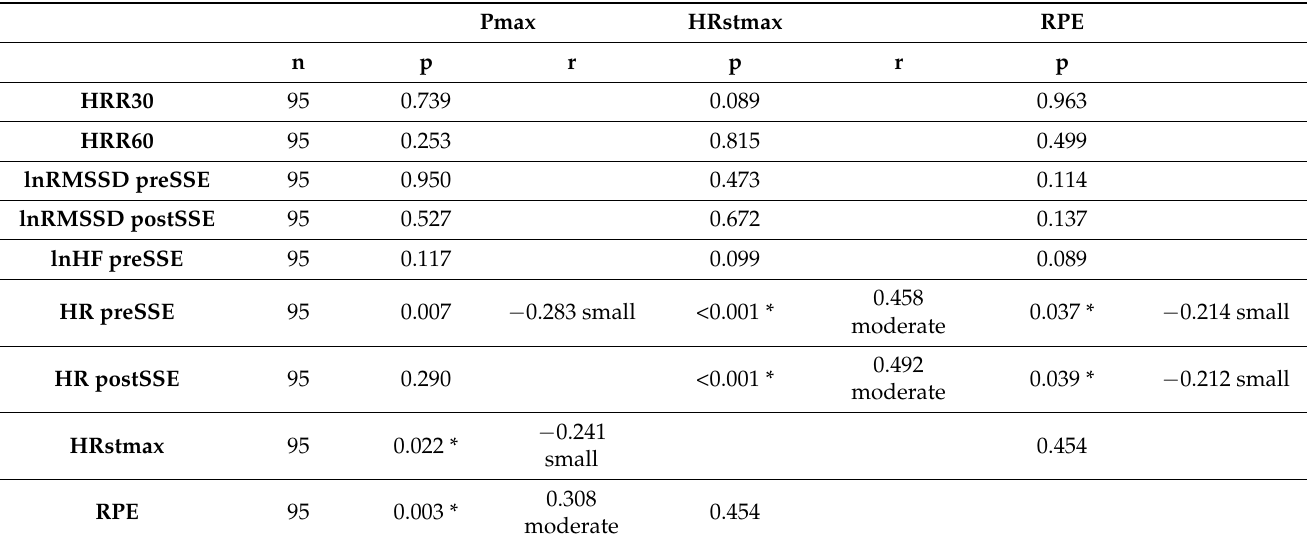
Table 3. Relationship between cardiac parasympathetic activity indices, heart rate, performance, and RPE combined for all data over the experimental